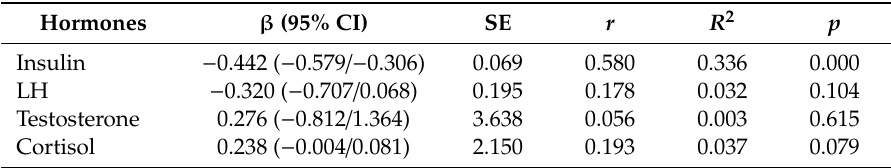
Table 6. Simple linear regression between the plasmatic concentration of hormones and km trained with intensity higher than VT 2 . Hormones β (95% CI) SE r R 2 Insulin − 0.442 ( − 0.579 / −